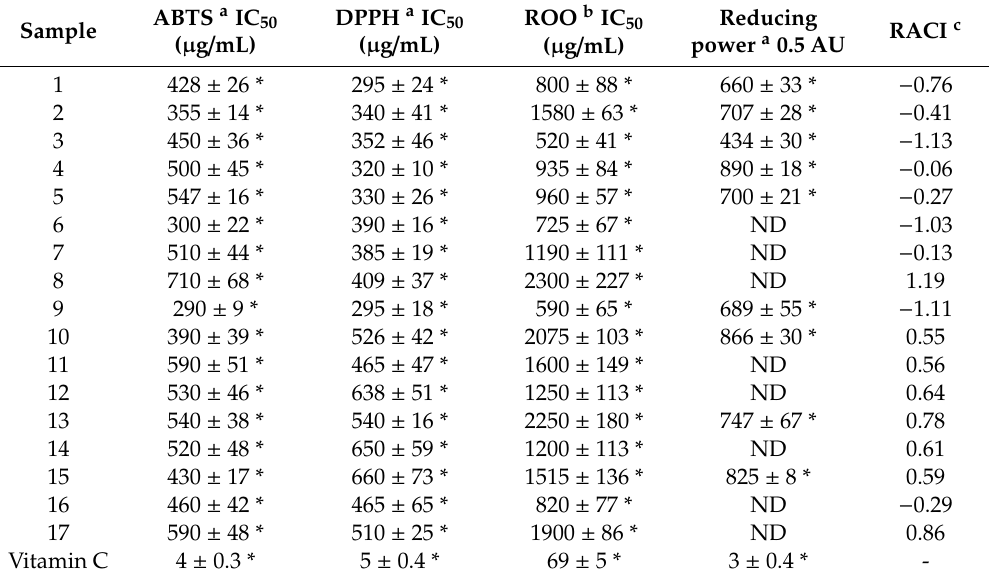
Table 2. Free-radical scavenging activity against DPPH • and ABTS • + radicals, protective activity against peroxyl radical (ROO)-induced DNA damage, and reducing power of the